Question: What visual encoding does this figure use to show its data?
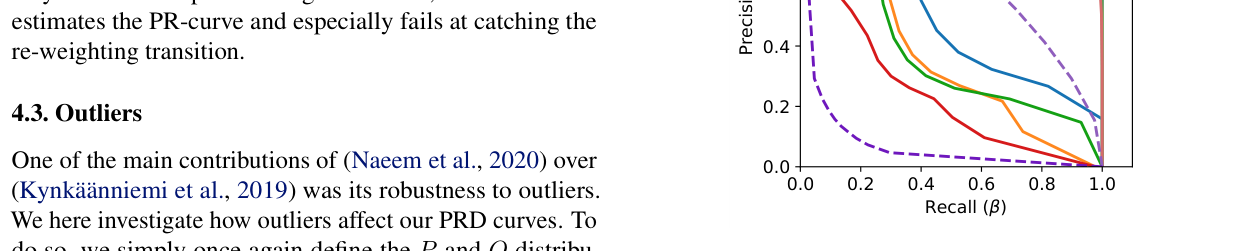
Answer: line